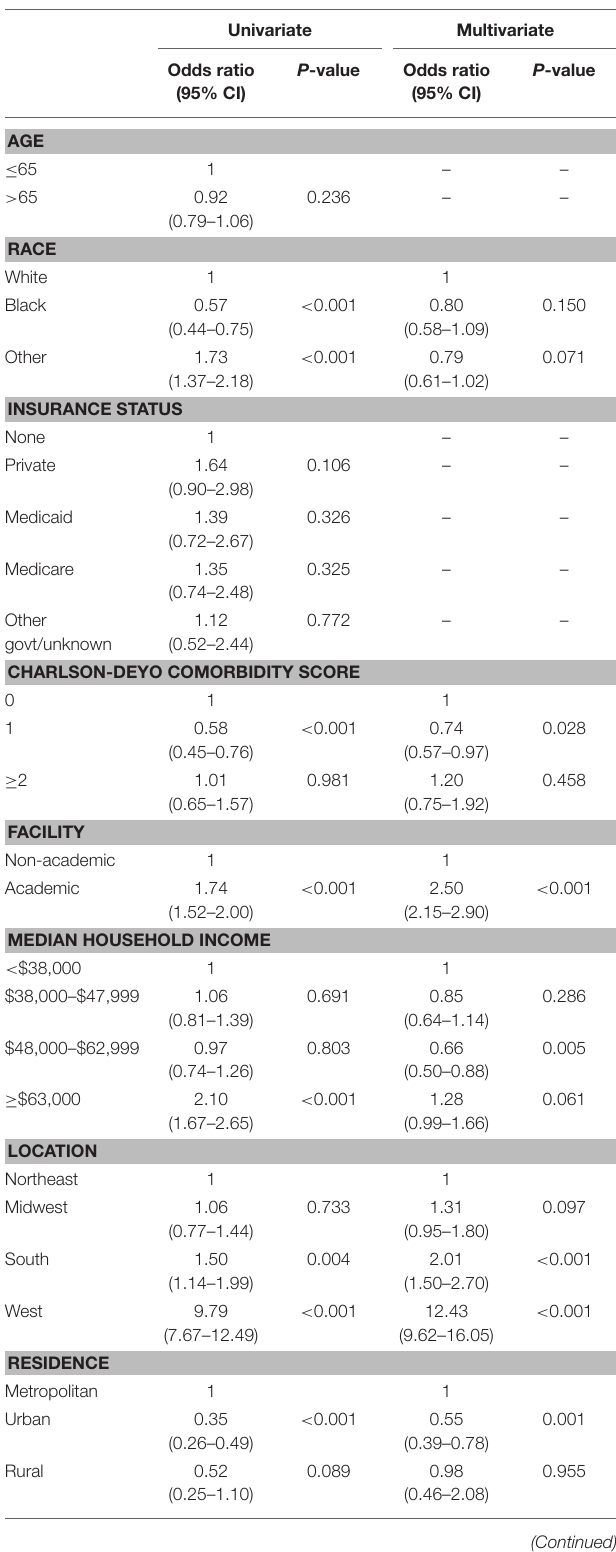
TABLE 1 | Univariate and multi-variate regression analysis to identify factors that predict for utilization of protons, relative to non-protons, in breast cancer